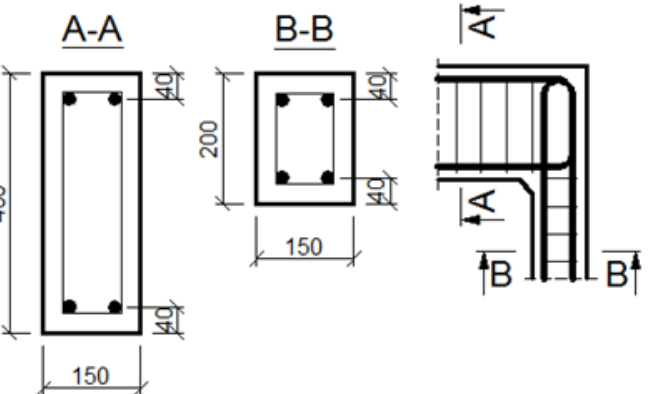
Figure 13. Geometry and main reinforcement for the case of elements with different cross section heights; dimension in (mm).